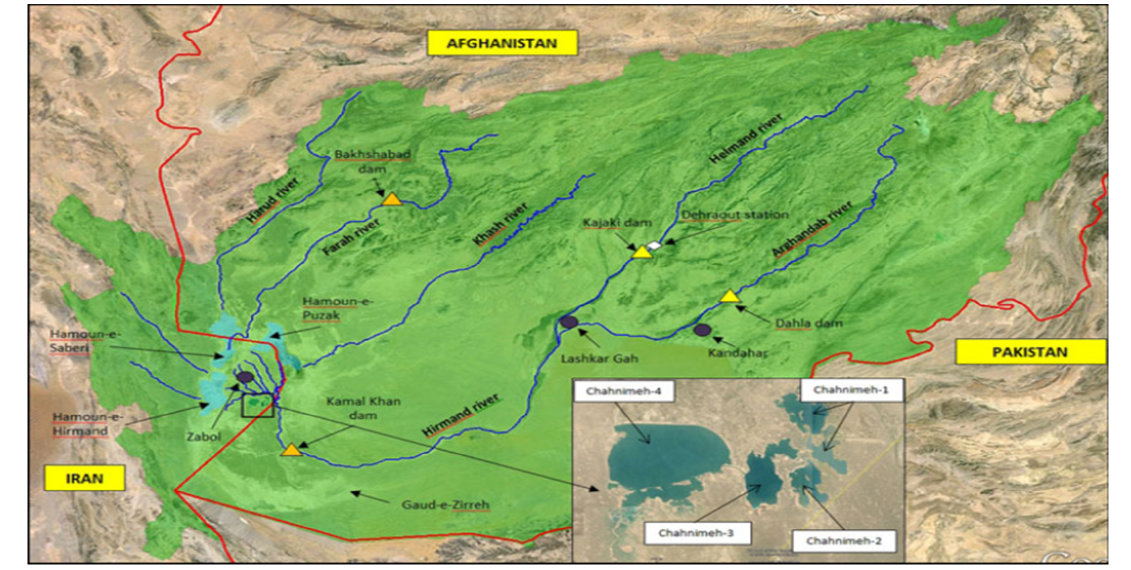
Figure 2. The location of the Hamoun wetlands on both sides of the political border of Iran and Afghanistan [69].